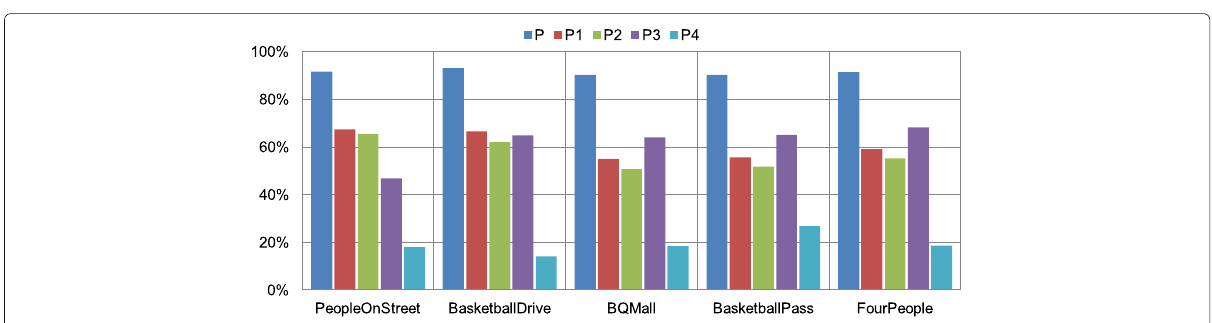
Fig. 7 Coding accuracy using various mode